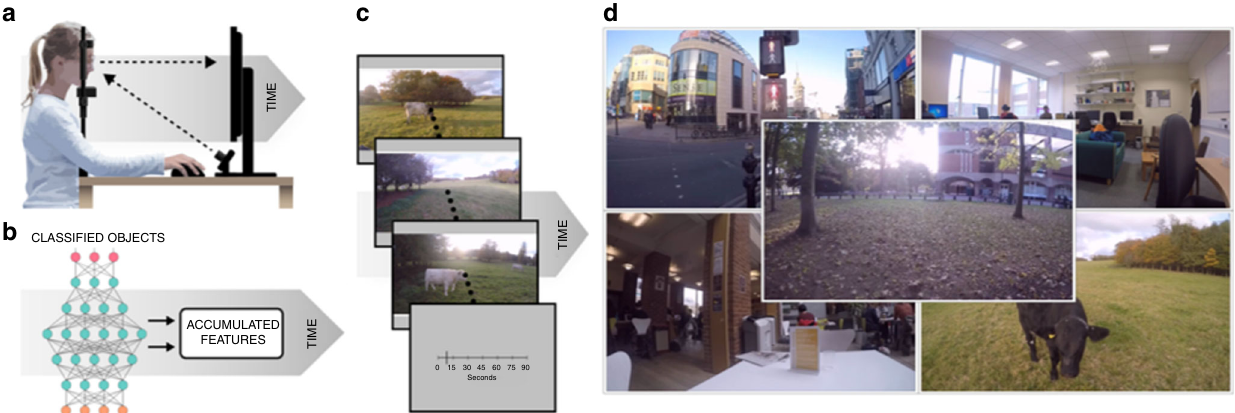
Fig. 1 Experimental apparatus and procedure. a Human participants observed videos of natural scenes and reported the apparent duration while we tracked their gaze direction. b Depiction of the high-level architecture of the model used for simulations (see also Fig. 2 below). c Frames from a video used as a stimulus for human participants and input for simulated experiments. Human participants provided reports of the duration of a video in seconds using a visual analogue scale. d Videos used as stimuli for the human experiment and input for the model experiments included scenes recorded walking around a city (top left), in an of fi ce (top right), in a cafe (bottom left), walking in the countryside (bottom right) and walking around a leafy campus